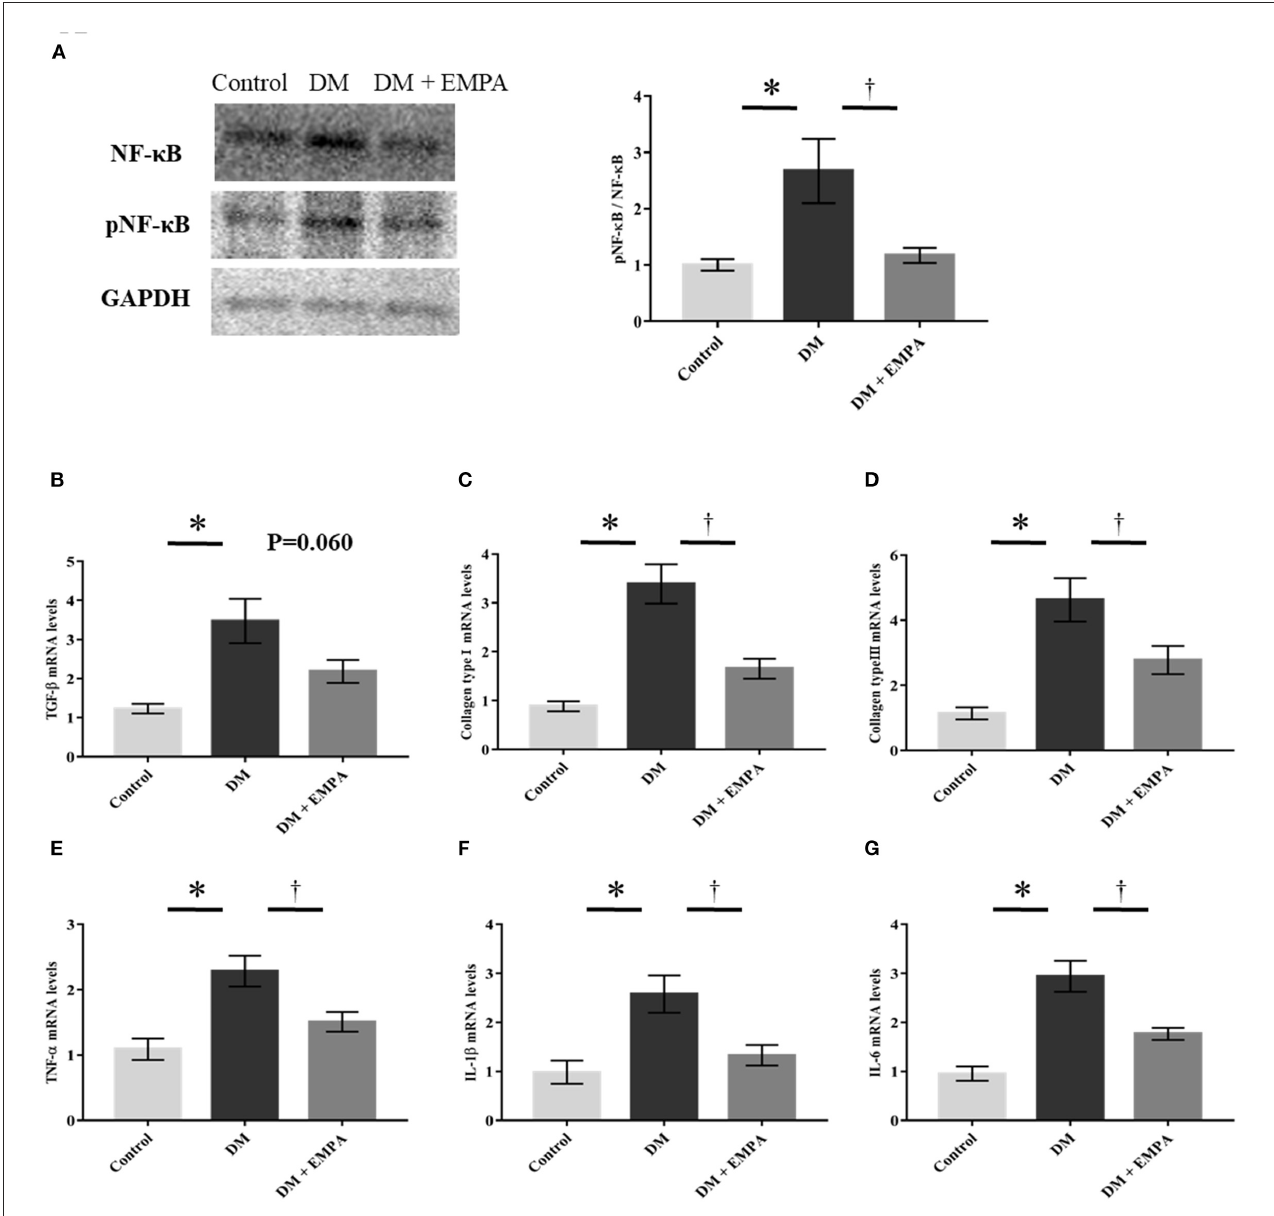
FIGURE3 Studies on fibrotic and inflammatory signaling pathway. (A) Representative western blot results and analysis for the expression of NF- κ B and phosphorylated NF- κ B (pNF- κ B). The value is represented as the ratio of pNF- κ B to NF- κ B ( n = 6 per group). (B–G) Relative mRNA levels of TGF- β , collagen type I, collagen type III, TNF- α , IL-1 β and IL-6 were measured by quantitative real-time RT-PCR ( n = 8 per group). Data are expressed as mean ± SE. * p < 0.05: vs. Control, † p < 0.05: vs. DM (One-way repeated ANOVA post hoc Tukey’s multiple-comparison test). NF- κ B, nuclear factor- κ B; GAPDH, glyceraldehyde 3-phosphate dehydrogenase; TGF- β , transforming growth factor- β ; TNF- α , tumor necrosis factor- α ; IL, interleukin; DM, diabetes; EMPA,